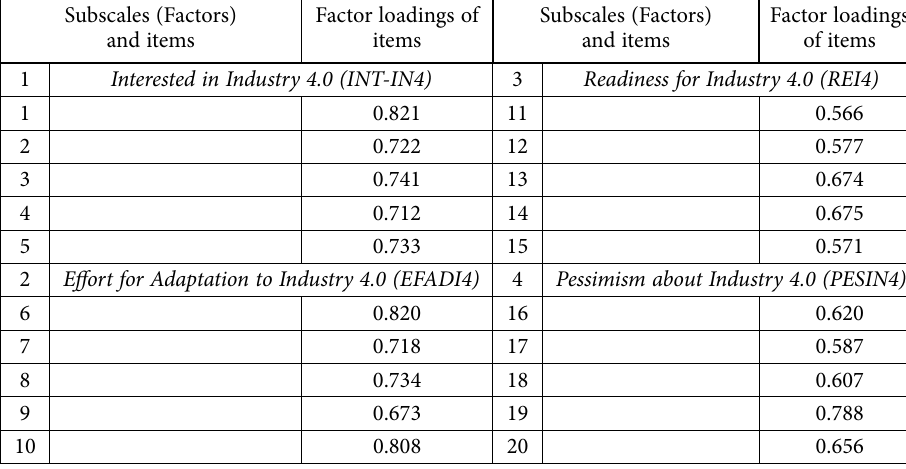
Table 3. The measurement scale developed through the pilot study and the factor loadings Subscales (Factors) and items